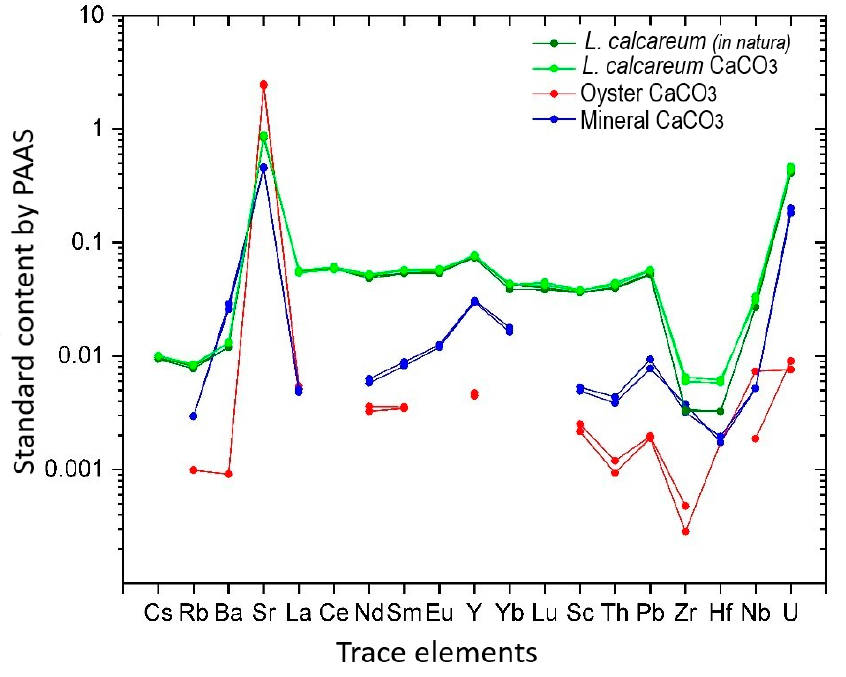
Figure 9. Distribution of trace elements in the three CaCO 3 samples, normalised by the average composition of the earth’s crust [56].